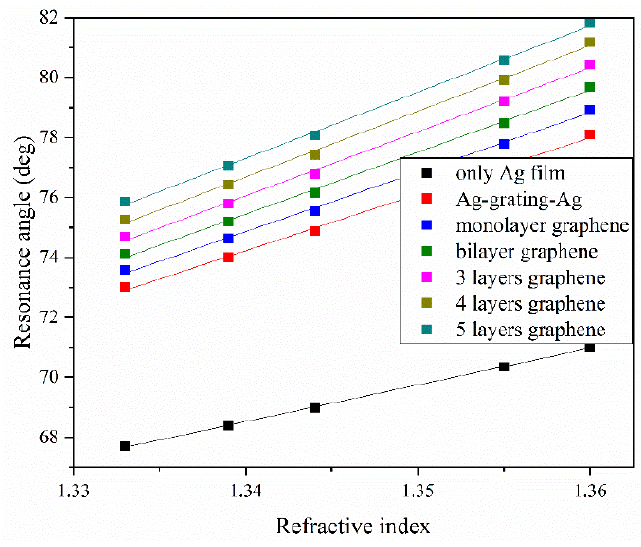
Figure 9. Linear fitting curves of resonance angle as a function of refractive index with different configurations. The refractive index of the ethylene solutions changed from 1.333 to 1.360.